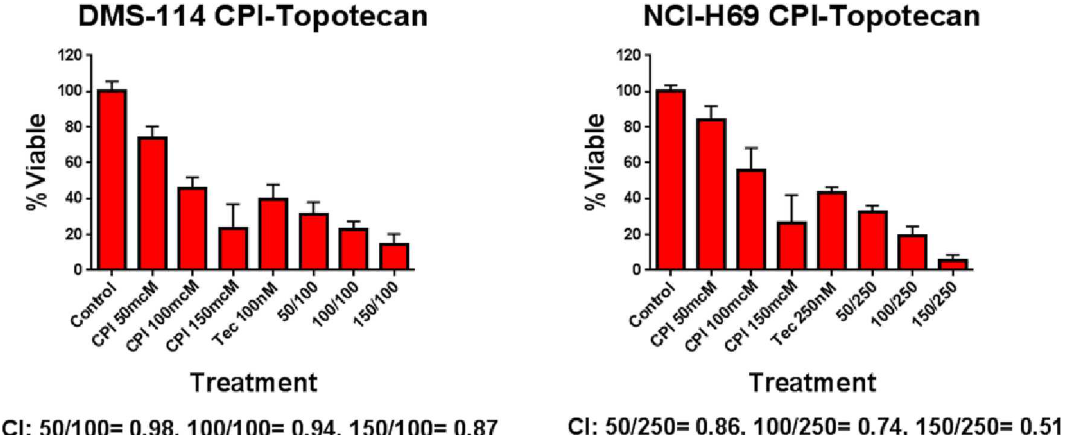
Fig 4. In vitro assessment of the combination of CPI-613 with topotecan. DMS-114 and NCI-H69 SCLC cell lines were exposed to the indicateddrug for 72 hours and then cell viability was assessed. Combinatorial indices were calculatedfor the indicateddrug combinations. CI = Combinatorial Index, CPI = CPI-613, Tec = Topotecan.